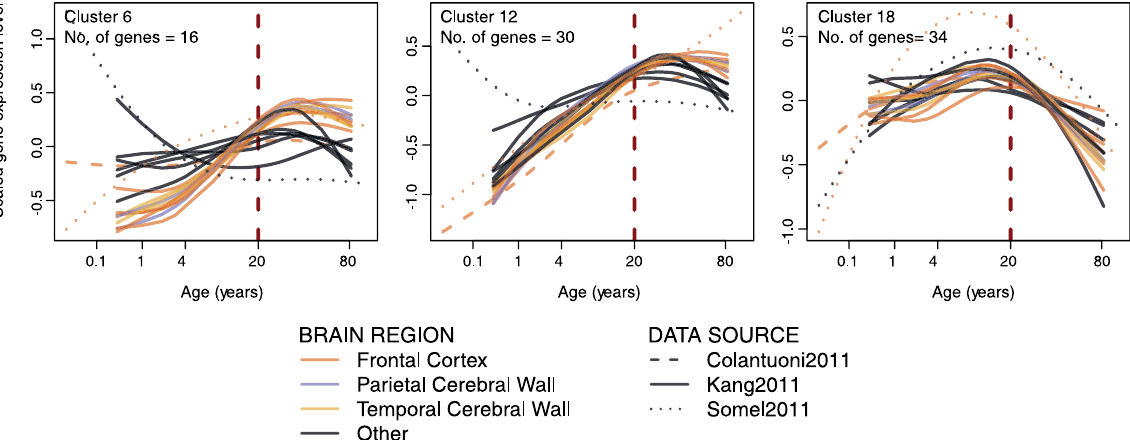
Figure 5. Three examples of expression-age trajectories among clusters of synapse-related and up-down- enriched GO BP categories (Group 9 in Fig. 3). The y-axis shows the scaled expression level and x-axis shows the age of samples on the fourth root scale. The spline curves indicate the mean expression change with age among cluster member genes for each dataset and brain region (for all of the clusters see Figure S11). The three clusters were chosen for showing peak expression at ages earlier or later than 20 years of